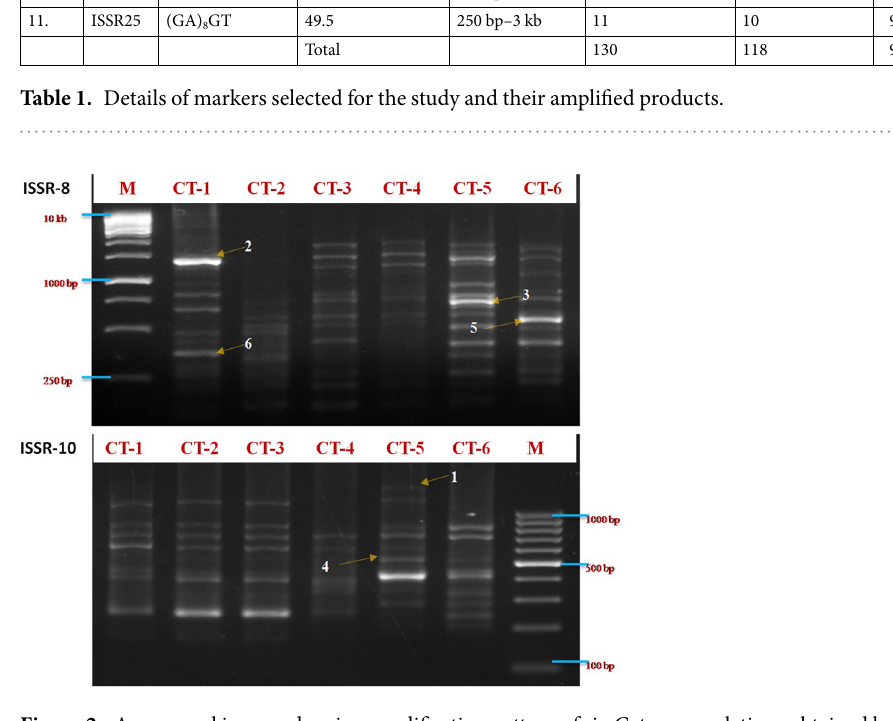
Figure 2. Agarose gel images showing amplification pattern of six C. tora populations obtained by ISSR-8 and ISSR-10 indicating selected polymorphic bands for the authentication of C. tora